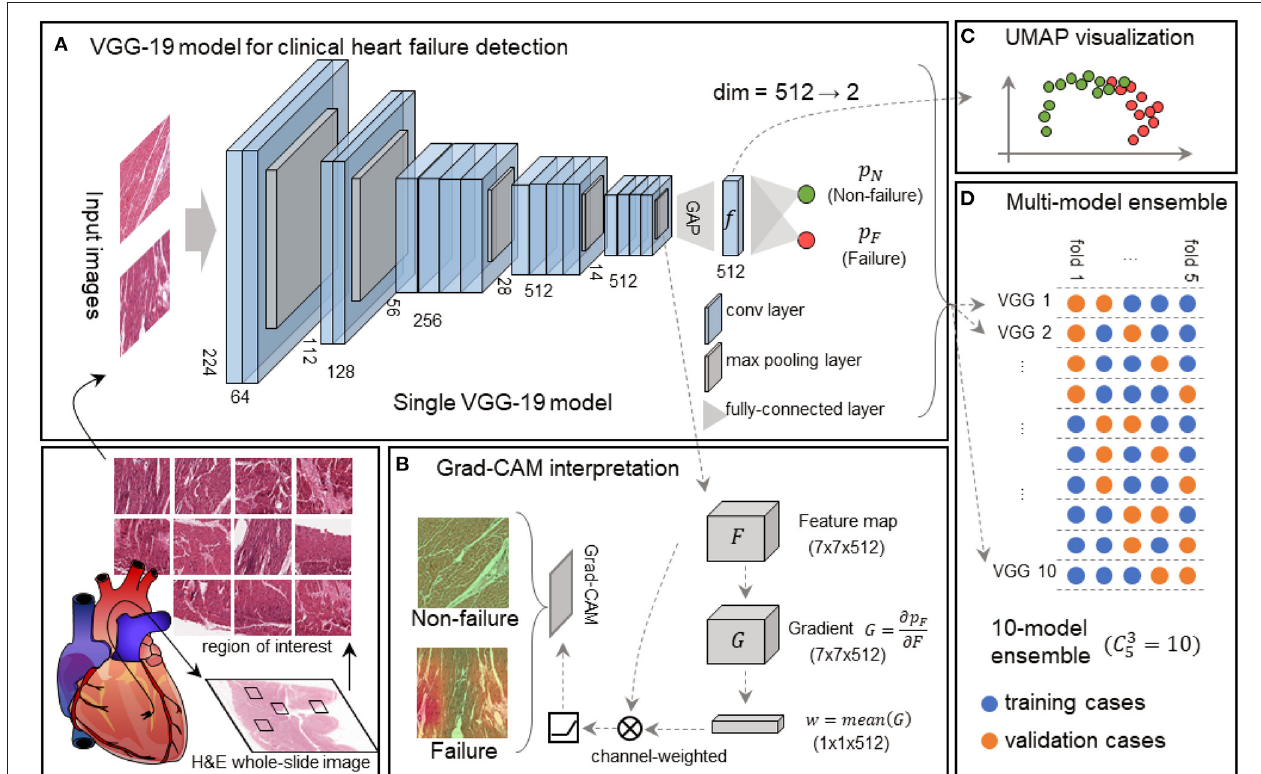
FIGURE 1 | Framework of the interpretable VGG-19 model with Grad-CAM and UMAP embedding for heart failure detection. (A) A schematic diagram highlights the basic pipeline from the myocardial section to digital prediction. The feature extractor of this single VGG-19 network includes 16 convolutional layers and 5 max-pooling layers, and the classifier is composed of a global average pooling (GAP) layer and a classification layer. This model is trained to discriminate failure and non-failure regions of interest (ROIs) without explicit pathological patterns. dim, dimension. (B) Grad-CAM generates attention maps for failure and non-failure cases, following the convolution and rectified linear unit (ReLU). (C) UMAP in the deep feature space converts 512-dimension features to 2-dimension visualization, elucidating the model outputs and intermediate features made by the VGG-19 model. (D) The 10-model ensembling is generated by a 5-fold cross-validation manner, and each fold is used for sub-model validation four